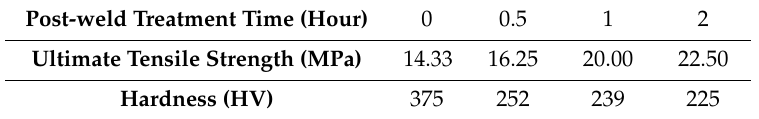
Table 21. Properties of martensitic stainless steel at di ff erent post-weld treatment times